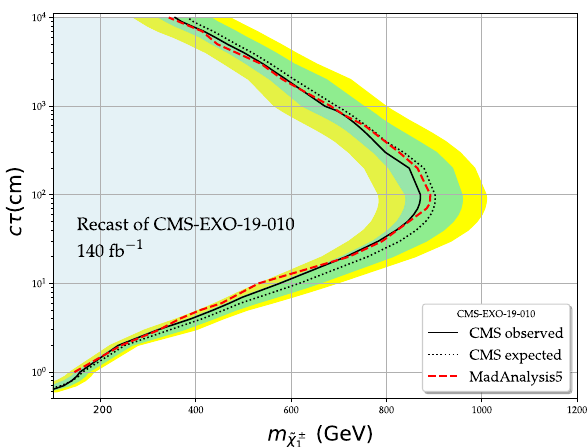
Fig. 6 Comparison of the exclusion curve obtained using the Mad- Analysis 5 (SFS) implementation of the CMS disappearing track search and the official curves available from the analysis publication itself